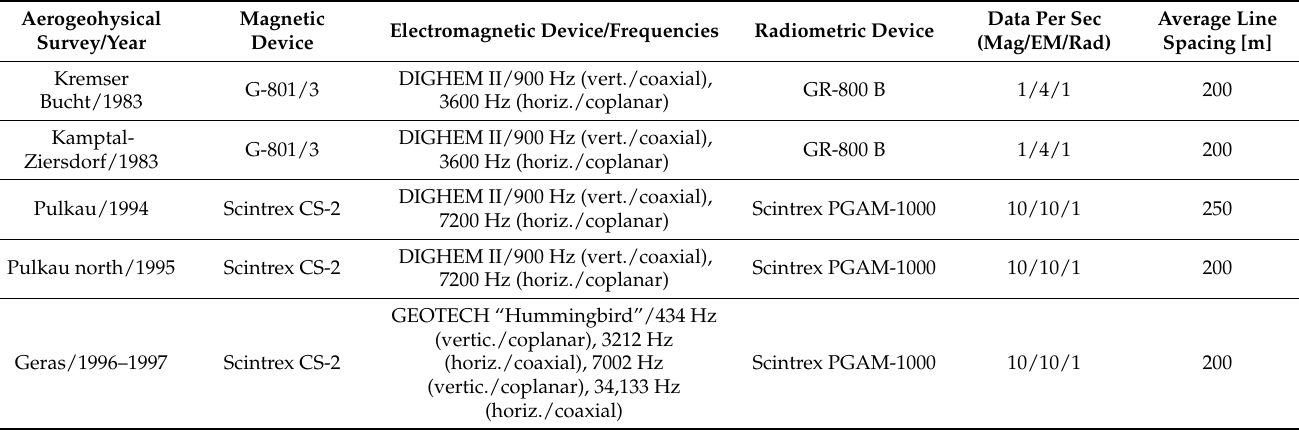
Table 1. Varying technical equipment and survey specification of aerogeophysical data survey which builds the basis of new processing